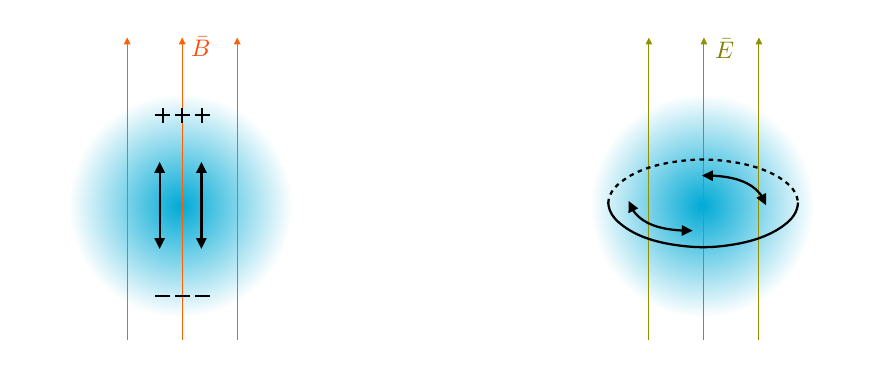
Figure 2 . The effective charge and current density (dipoles) induced by the presence of a soliton in an external electromagnetic field background. The left image shows a charge dipole aligned with the external magnetic field, and the right image shows a current dipole in a plane normal to the external electric field. The charge density and current density oscillate in time, generating dipole